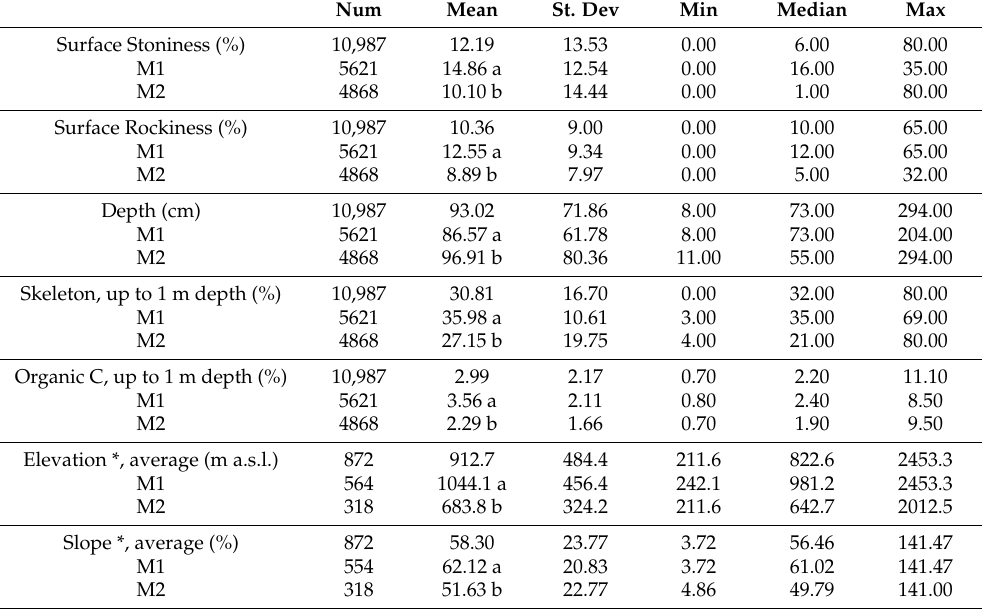
Table 2. Descriptive statistics of the available soil information that referred to the delineation of the soil map at the scale of 1:250,000 and presented for the whole study area and for the M1 and M2 soil regions. Different letters indicate significant differences according to ANOVA ( p < 0.05). * Topographic variables (elevation and slope) were obtained from DTM for triggered landslides for which exact localization was known (N = 872). Different letters indicate significant differences according to ANOVA ( p <